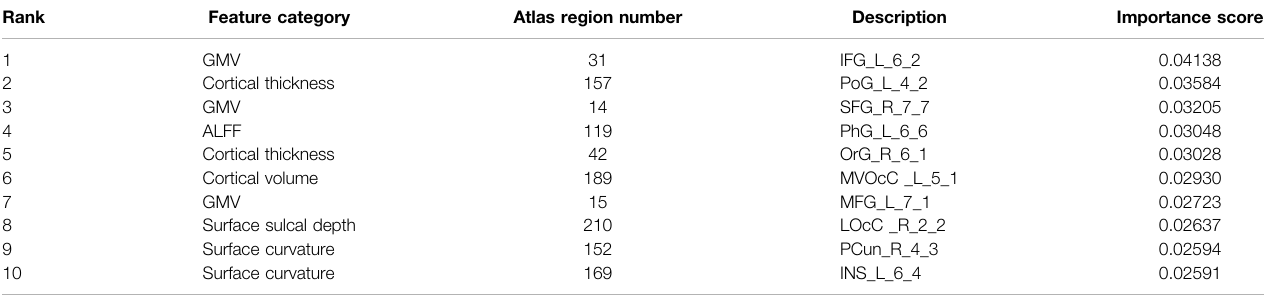
TABLE 4 | Top 10 important features obtained from the XGBoost classi fi er trained on the whole dataset.